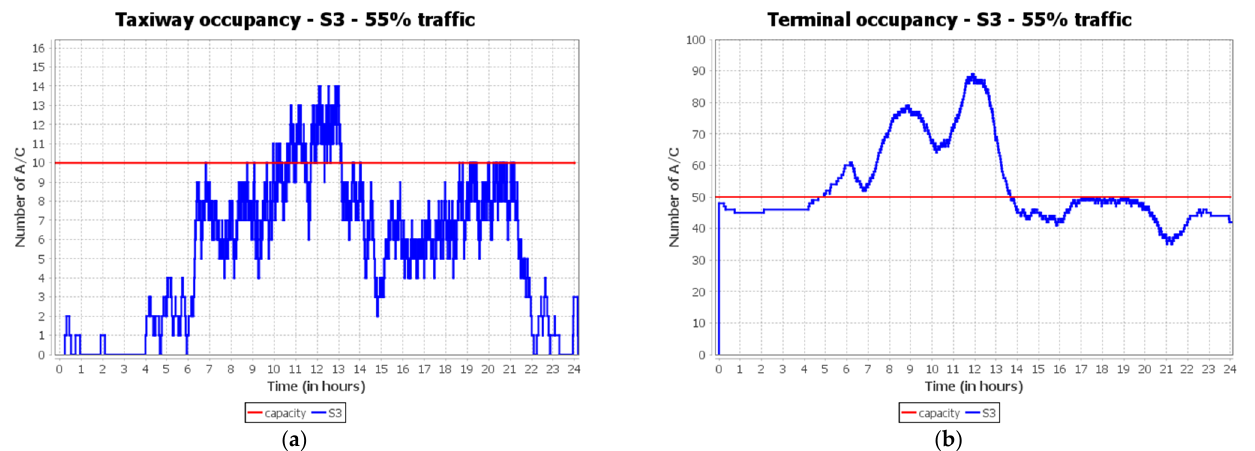
Figure 9. Taxiway ( a ) and terminal ( b ) occupancy scenario S3.